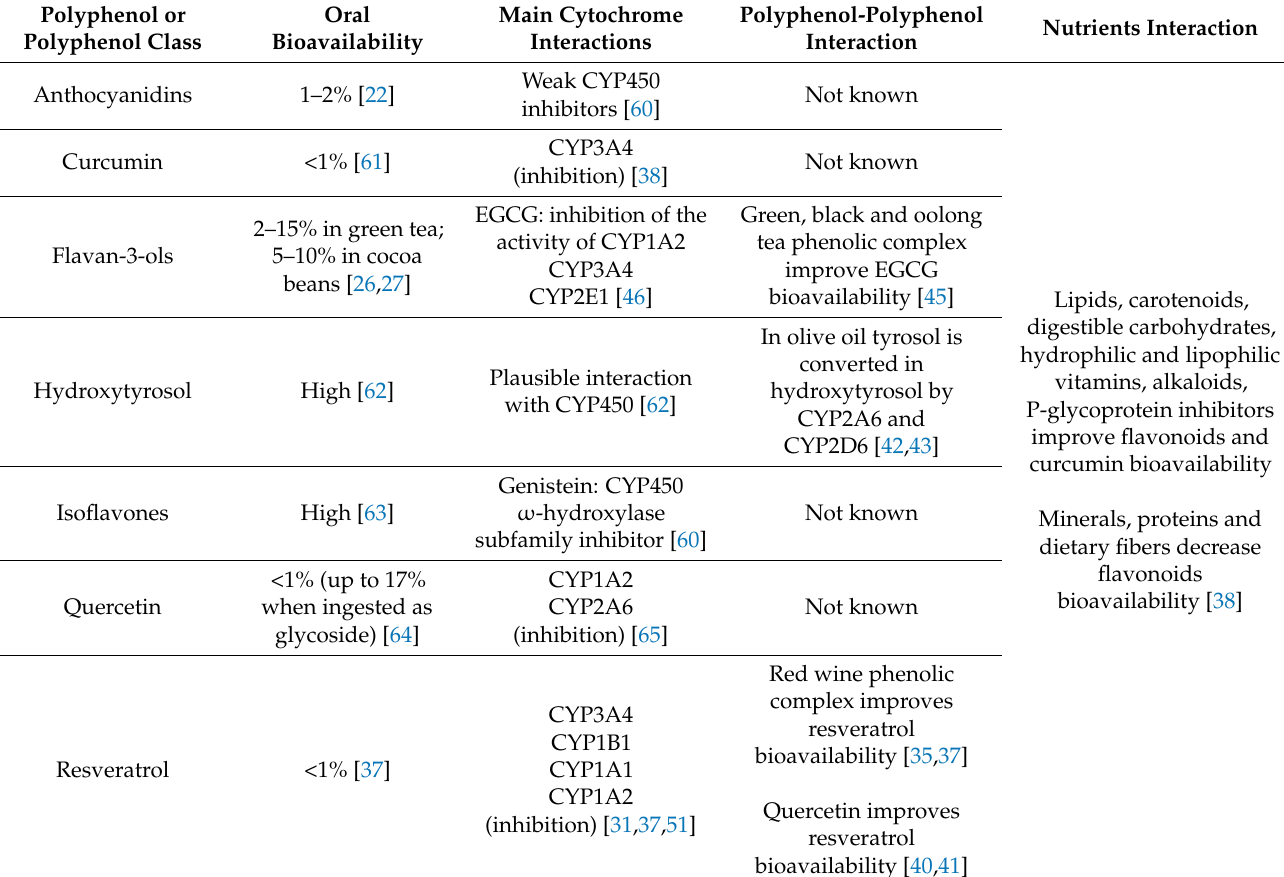
Table 1. Oral bioavailability of the most common dietary polyphenols, their interactions with different CYP450 isoforms and the effect in terms of modulation of bioavailability of polyphenols exerted by carbohydrates, lipid, proteins, minerals and other nutrients and food minor